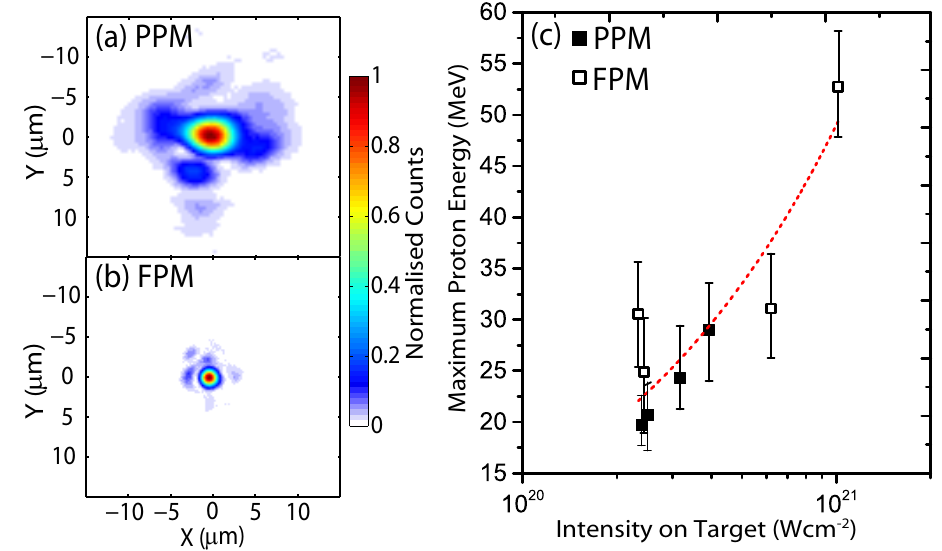
Figure 6. Measured laser focal spot spatial-intensity distributions using the Vulcan-PW laser, with low power (continuous wave (CW) operation) 1053 nm light, obtained for ( a ) a planar plasma mirror and ( b ) a focusing plasma mirror, at f 2 . ( c ) Plot of the measured maximum proton energy achieved using FPMs (open squares) and PPMs (closed squares), as a function of the laser intensity ( I L ). The red dashed line represents a simple fit of the form E pmax = a . I b , with b = ( 0.6 ± 0.1 ) (see for example L